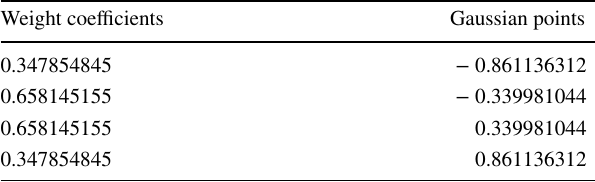
Table 1 Gaussian points and related weight coefficients Weight coefficients